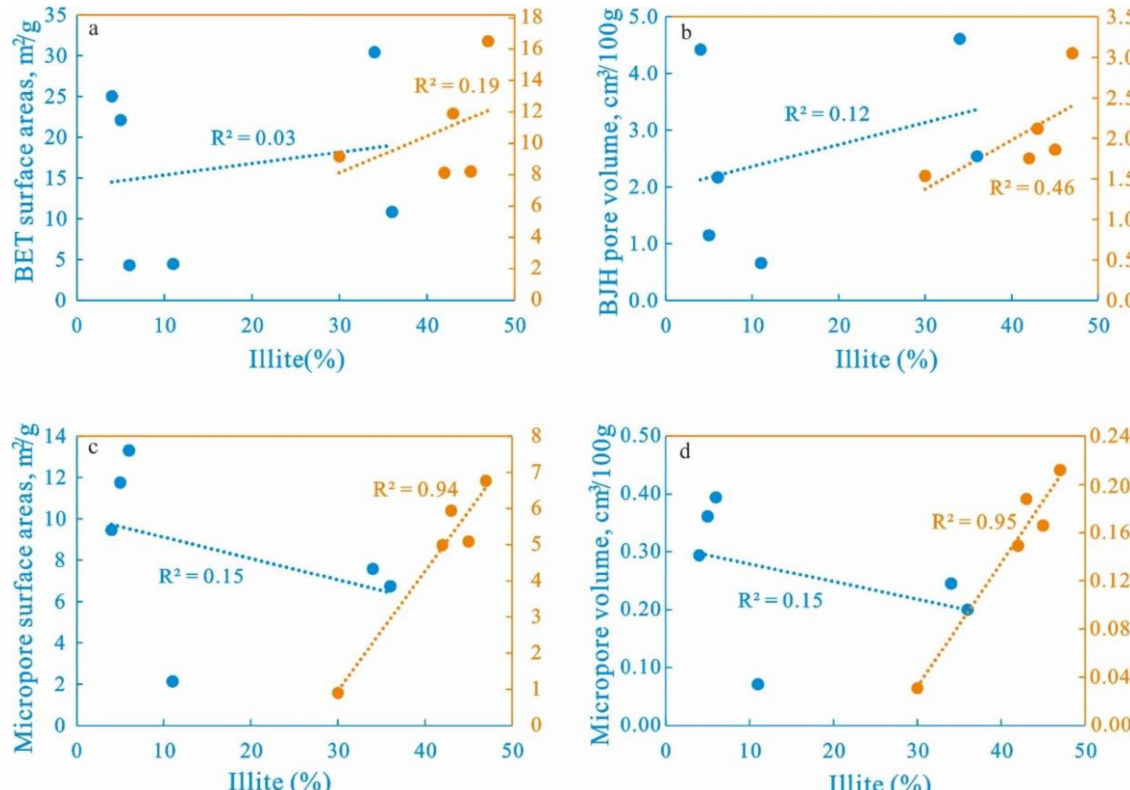
Figure 13. Mesopore surface areas and volume versus illite content ( a , b ); micropore surface areas and volume versus illite content ( c , d ) for siliceous shales (blue color) and argillaceous shales (orange